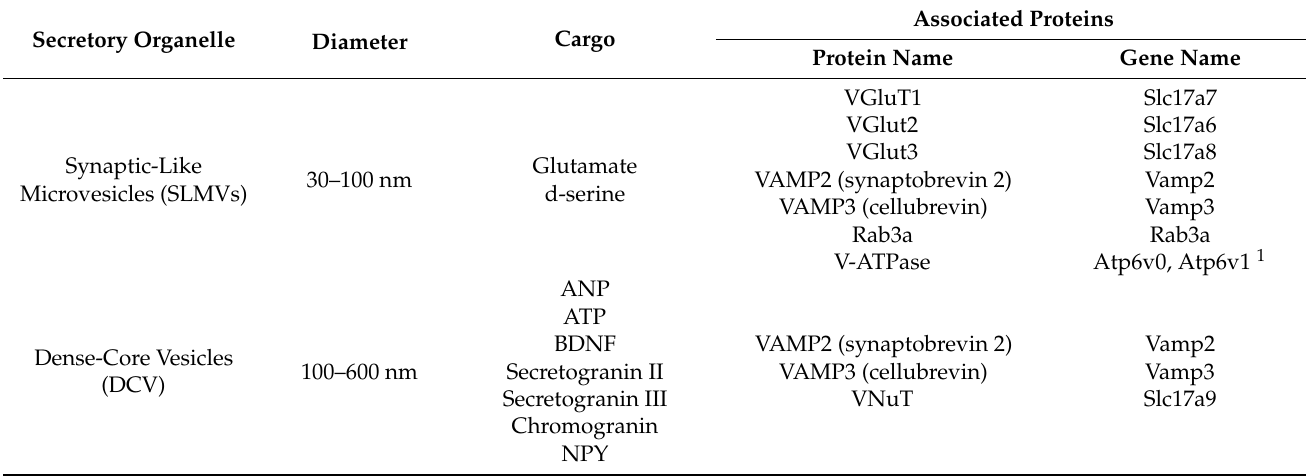
Table 1. Secretory vesicles undergoing exocytosis in